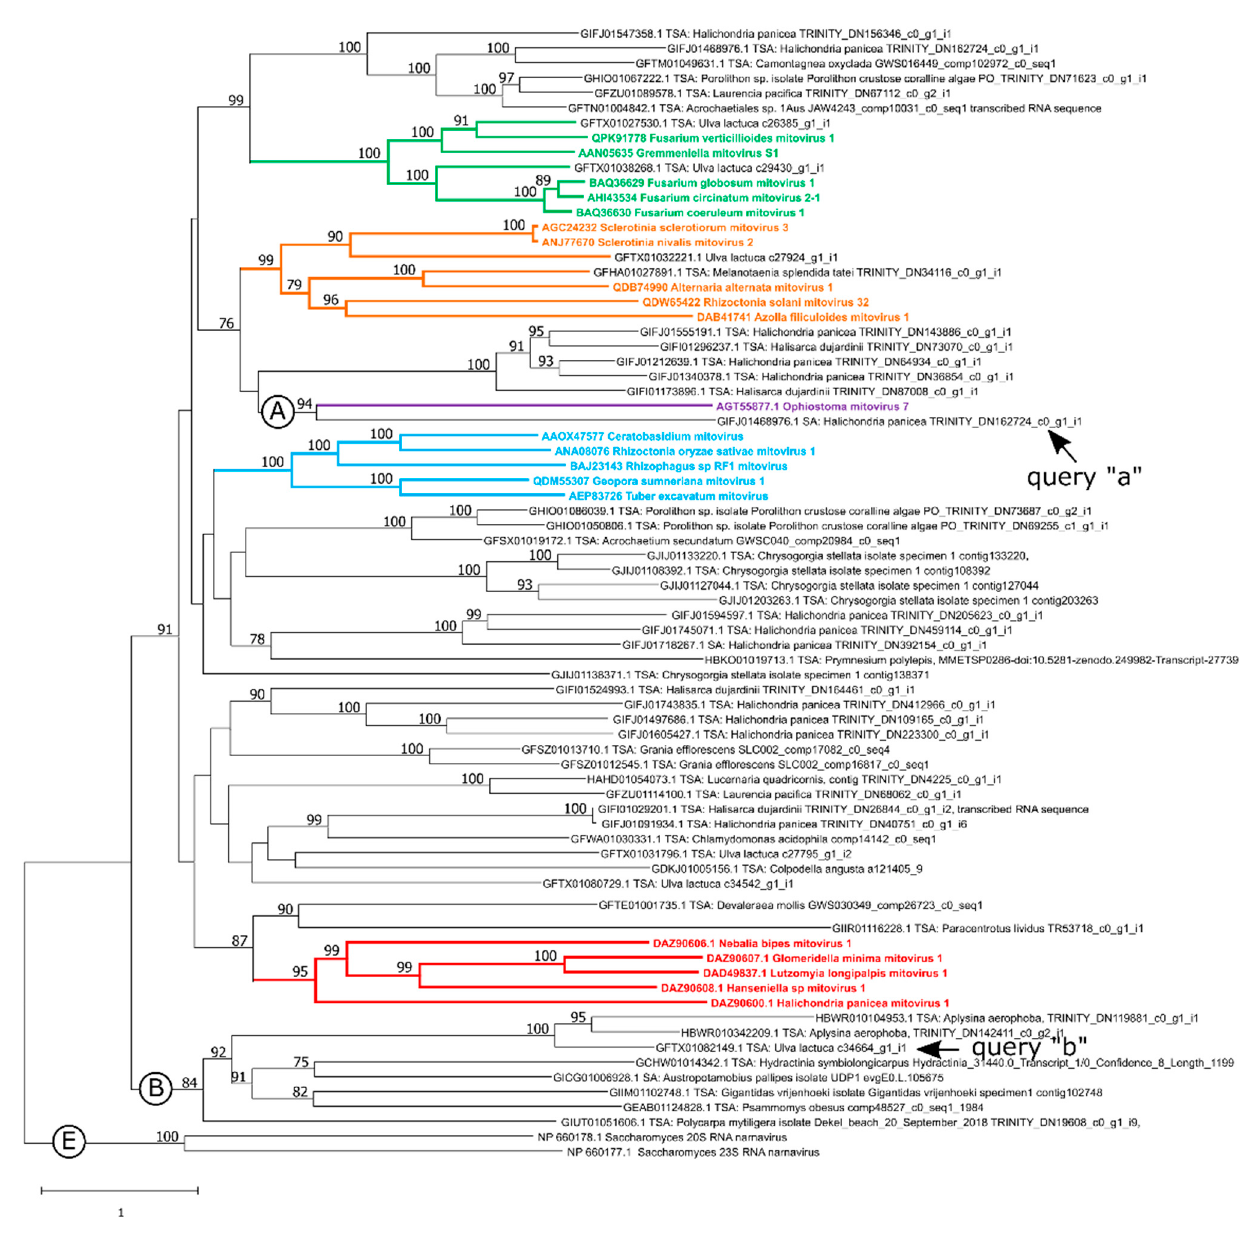
Figure 1. Generalized midpoint rooted tree of RNA replicase aa sequences. The deduced Mitovirus RdRps identified in the TSA database are labeled with the NCBI accession number, and the mitovirus formally accepted by the ICTV (colored branches) are labeled with the NCBI accession code and virus name. The color-coding of the branches: green, orange, cyan and purple indicates a member of the genus Unuamitovirus, Duamitovirus, Triamitovirus and Kvaramitovirus , respectively. Red branches indicate members of the recently proposed genus “kvinmitovirus”. Formal members are indicated in colored bold type. Clades discussed in the main text are indicated with a letter (“A” and “B”). Letter E indicates the external group (two Narnaviridae members). An arrow indicates the sequence used as the query to search for similar sequences deposited in open databases (details in the article). Sequence alignment: MAFFT (L-INS-i). Tree construction method: Maximum Likelihood. Evolutive model: LG+F+R6. Node support values are displayed as percentages (only values ≥ 75% are shown). The bar indicates one substitution (estimated median number) per alignment site.